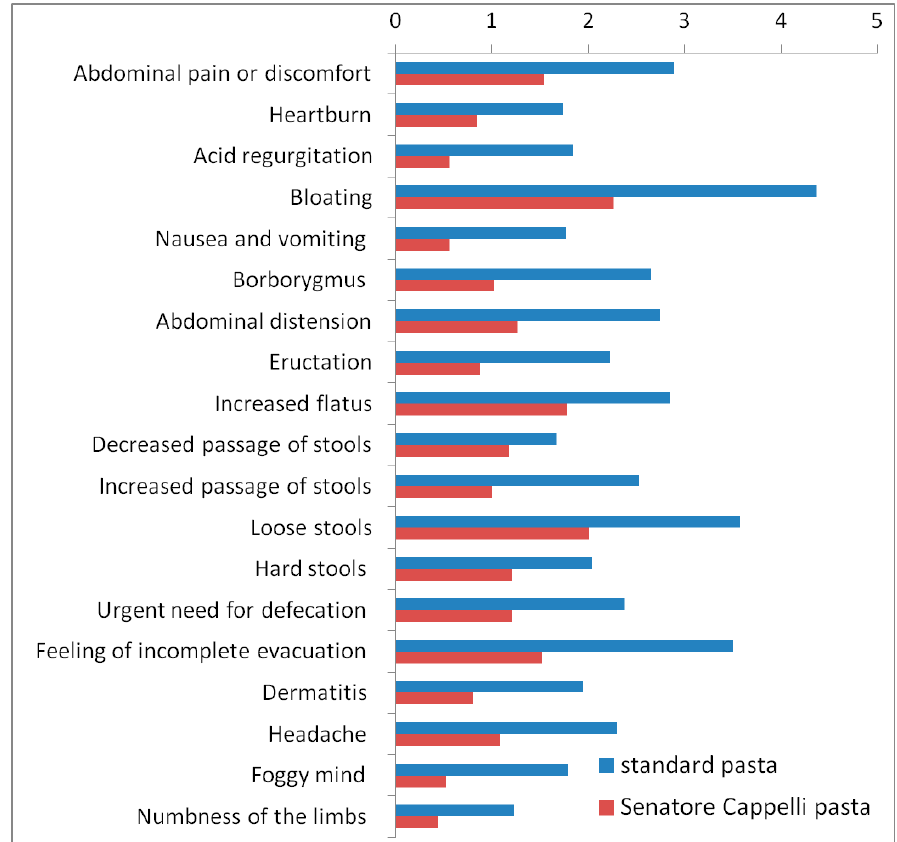
Figure 1. Average Gastrointestinal Symptom Rating Scale (GPRS) scores for intestinal, extra-intestinal, and overall symptoms in standard and Senatore Cappelli pasta groups.